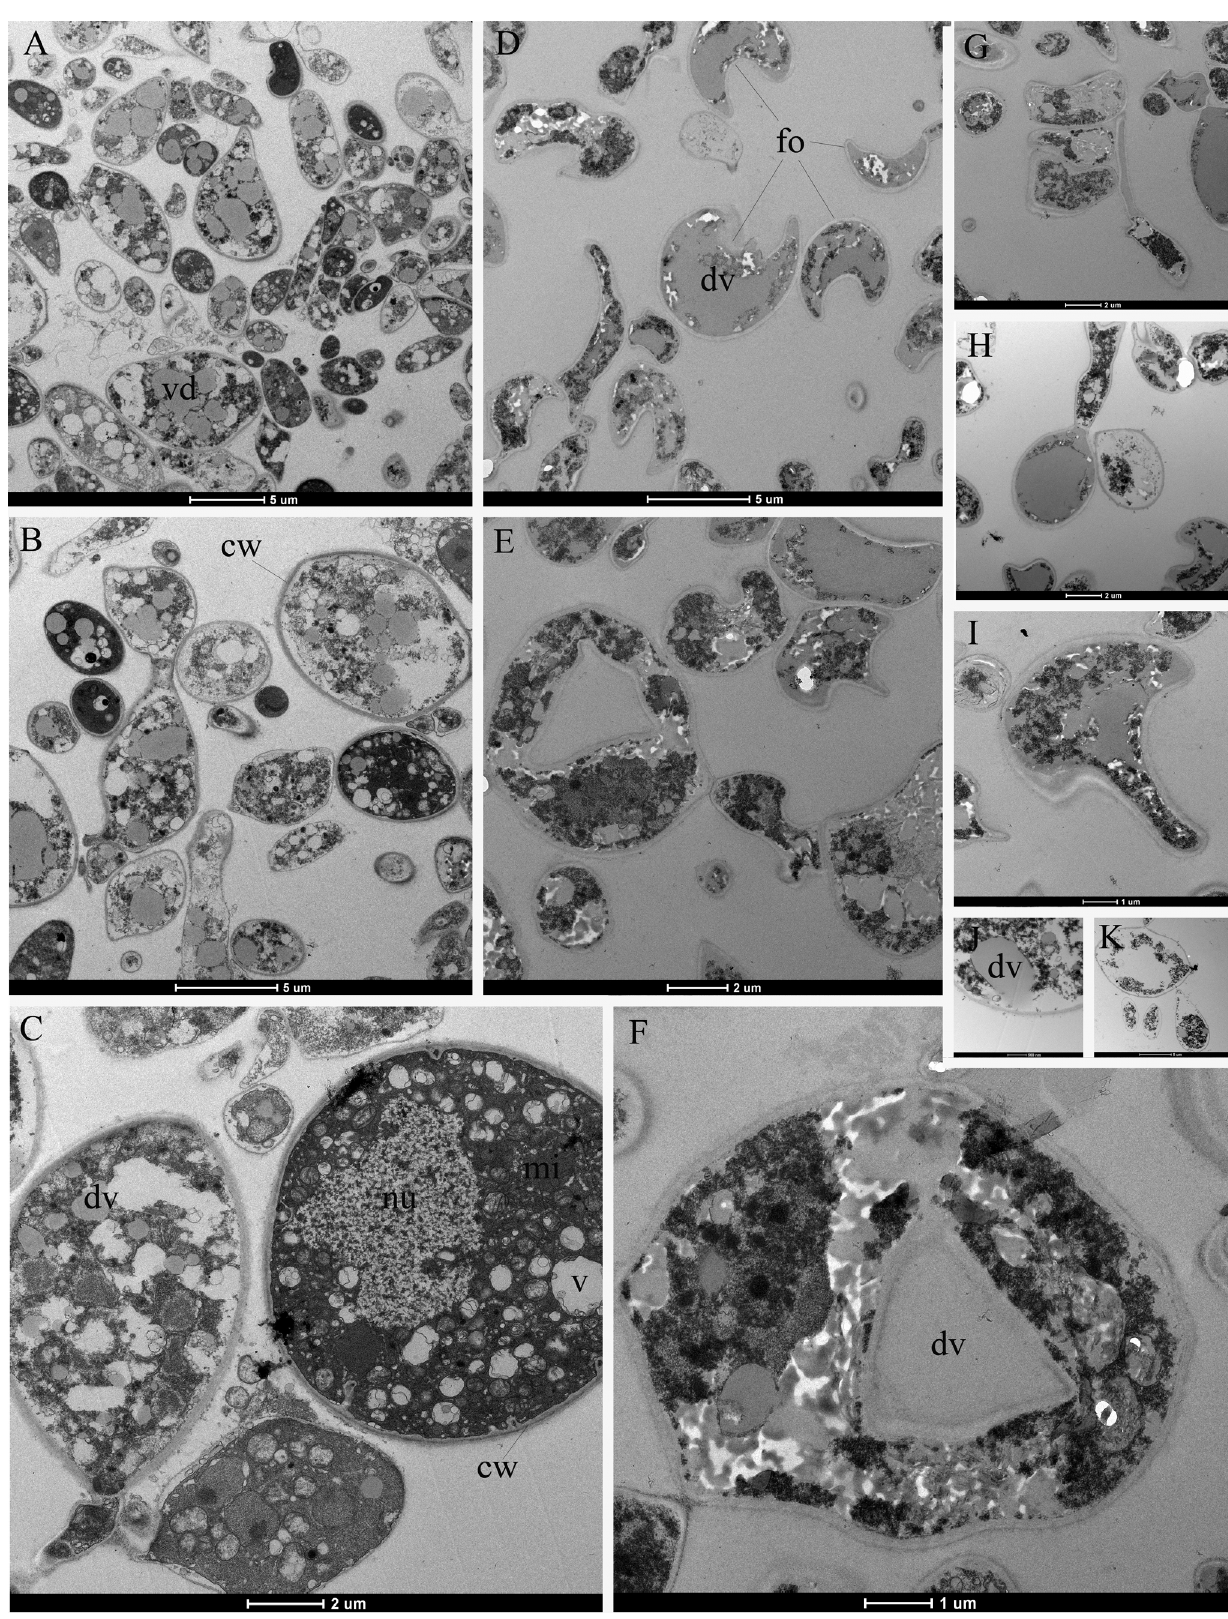
Figure 4. Transmission electron microscopy of yeast-phase cells of the standard Paracoccidioides brasiliensis (Pb18) strain. (A-C) Cells not treated with liriodenine. (D-K) Cells treated with liriodenine at the MIC of 31.2 μg.mL -1 . dv: dense vacuole; v: electron-lucent; nu: nucleus; mi: mitochondrion; cw: cell wall; fo: sickle